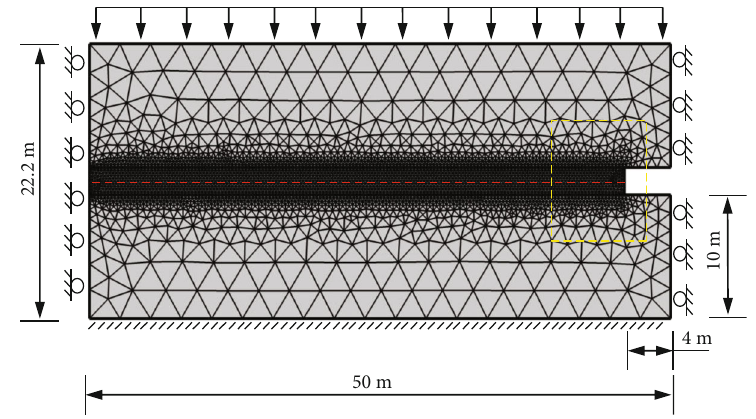
Figure 1: Geometric model. Table 1: The physical parameters. Parameters and units Value Elasticity modulus of coal E / (GPa) 3 Elasticity modulus of coal matrix E m